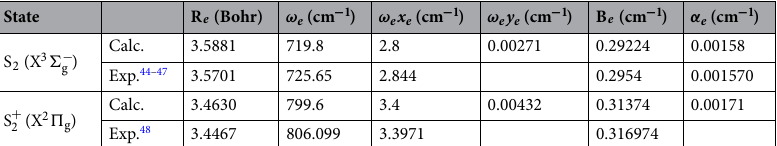
Table 2. Spectroscopic constants of the ground electronic states of S 2 (X 3 (cid:31) − g ) and S provided are the equilibrium distance R e , the harmonic wavenumber ω e , the anharmonic terms ω e x e and ω e y e , and the rotational constants B e and α e